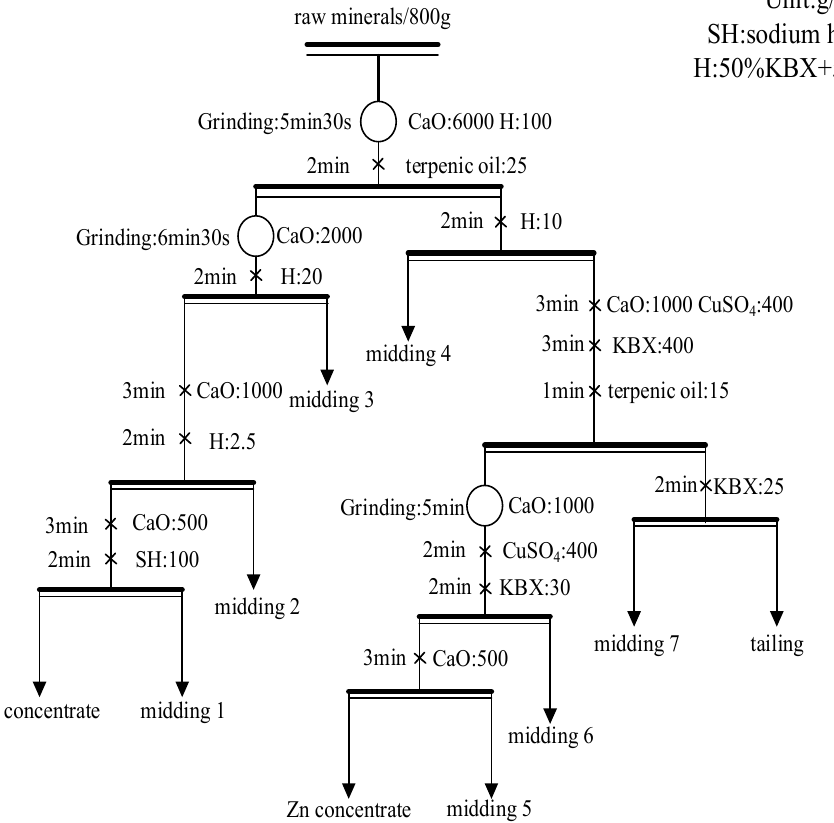
Figure 2. Flowsheet and corresponding experimental conditions of batch flotation tests using different types of water.